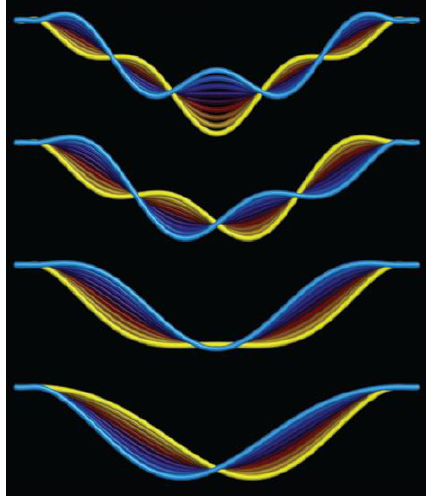
Figure 2. First four resonant modes of a carbon nanotube. Reused with permission from [73], Copyright 2004 Nature Publishing